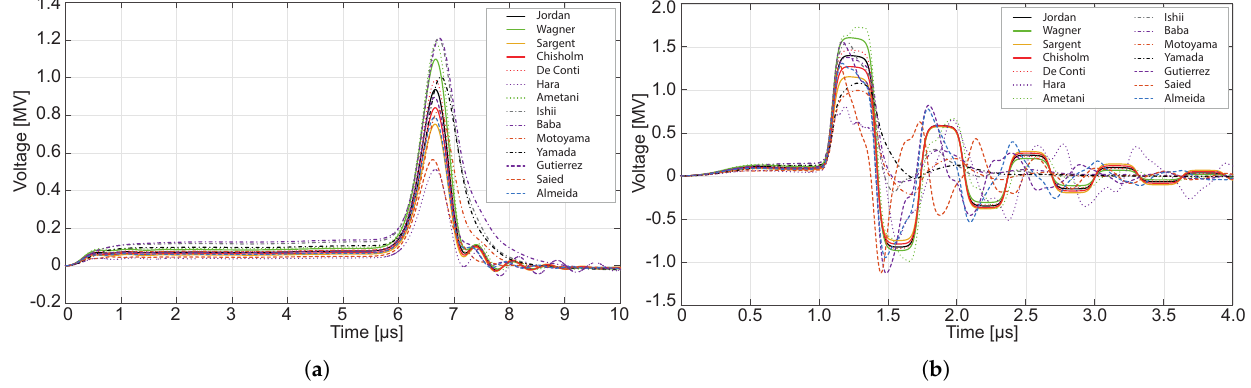
Figure 25. Voltage at the top of tower (b) over a PEC plane when the first and subsequent stroke currents in Figure 20 are injected. ( a ) Response to the first stroke current. ( b ) Response to the subsequent stroke current.